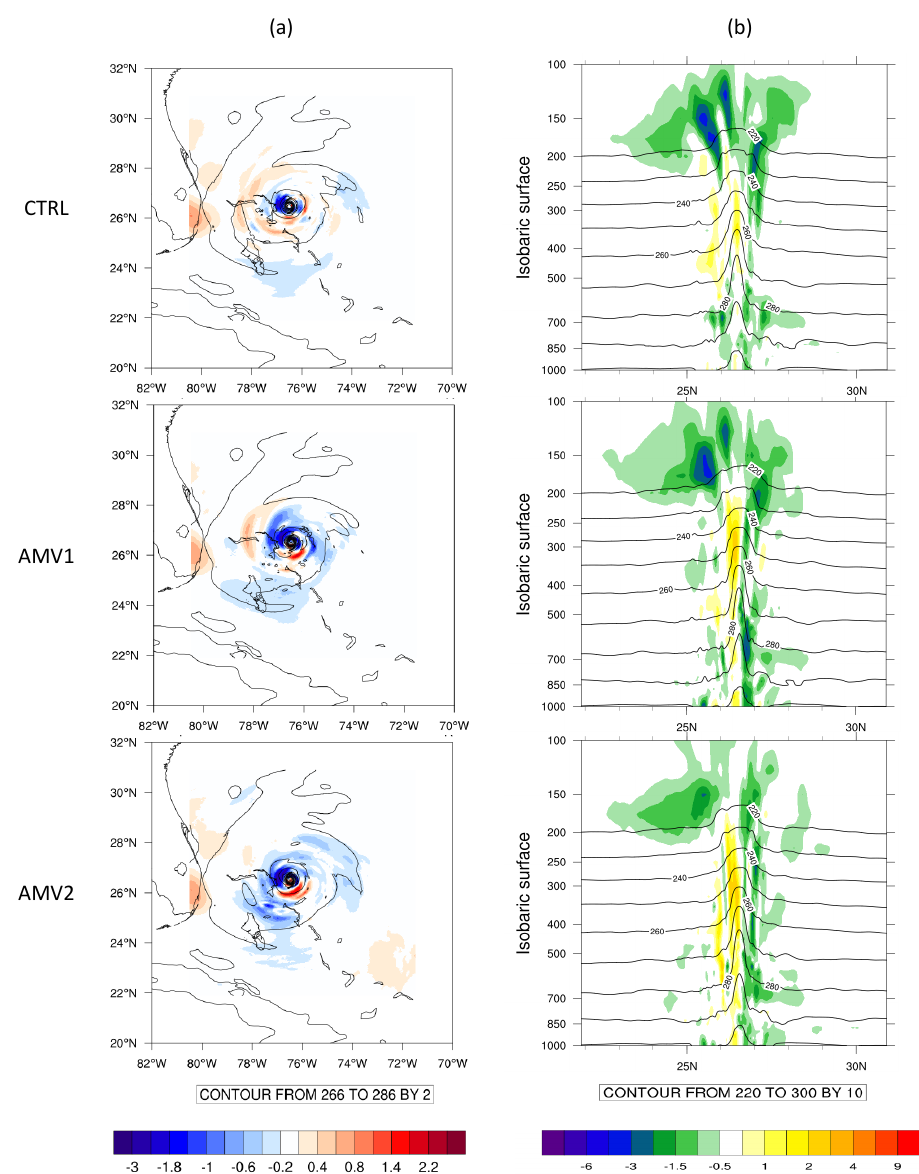
Figure 9. First guess temperature [K] in black contours and temperature analysis increment (analysis—first guess) in color shades [K]. ( a ) 500 hPa isobaric level. ( b ) Meridional cross section of the inner core domain taken through the center of the storm defined by the NHC best track at 26.5 oN, 76.5 oW for Hurricane Dorian at 12 UTC on 1 September 2019 for (top) CTRL, (center) AMV1 and (bottom) AMV2. Black contours are first-guess temperature fields. Shaded colors are temperature analysis increments. Temperature analysis increments at 500 hPa (Figure 9a) show